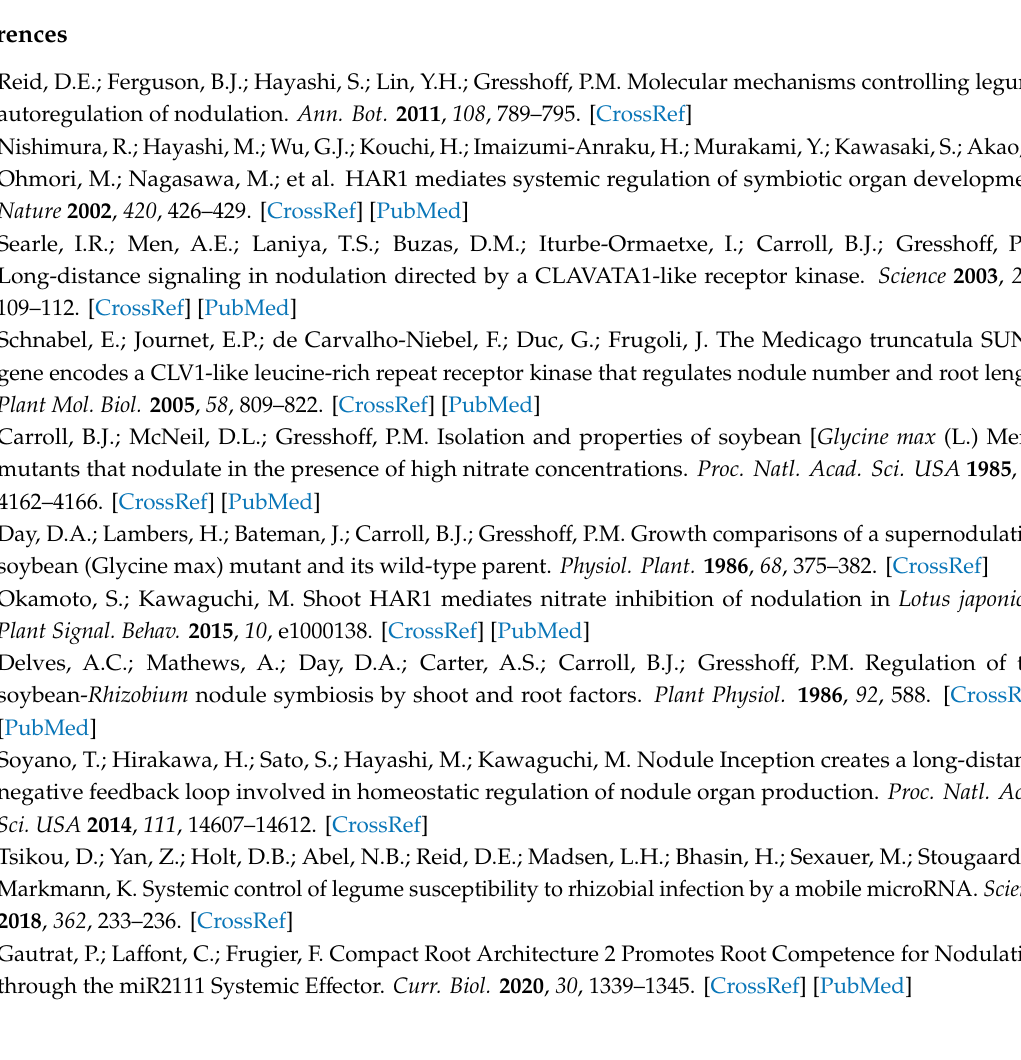
(A), MtCLE35 expression at 0, 4, 10, 14 and 28 dpi according to theSmall Secreted Peptide Gene Expression Atlas (SSP-GEA) available in The Medicago truncatula Small Secreted Peptide Database (https: // mtsspdb.noble.org [28] (B); Figure S4: Examples of nodulation phenotypes of composite wild-type plants containing both transgenic GFP-positive control ( β -glucuronidase (GUS))-overexpressing) (A and B) and MtCLE35 -overexpressing (C–F) roots and non-transgenic GFP-negative roots. White arrows indicate non-transgenic GFP-negative roots exhibiting faint autofluorescence. Red arrows point at nodules on GFP-positive transgenic roots, yellow arrows point at nodules on GFP-negative non-transgenic roots; Figure S5: Examples of nodulation phenotypes of composite sunn-4 mutant plants containing both transgenic GFP-positive control ( GUS -overexpressing) (A and B) and MtCLE35 -overexpressing(C–F)rootsandnon-transgenicGFP-negativeroots. Whitearrowsindicatenon-transgenic GFP-negative roots exhibiting faint autofluorescence. Red arrows point at nodules on GFP-positive transgenic roots, yellow arrows point at nodules on GFP-negative non-transgenic